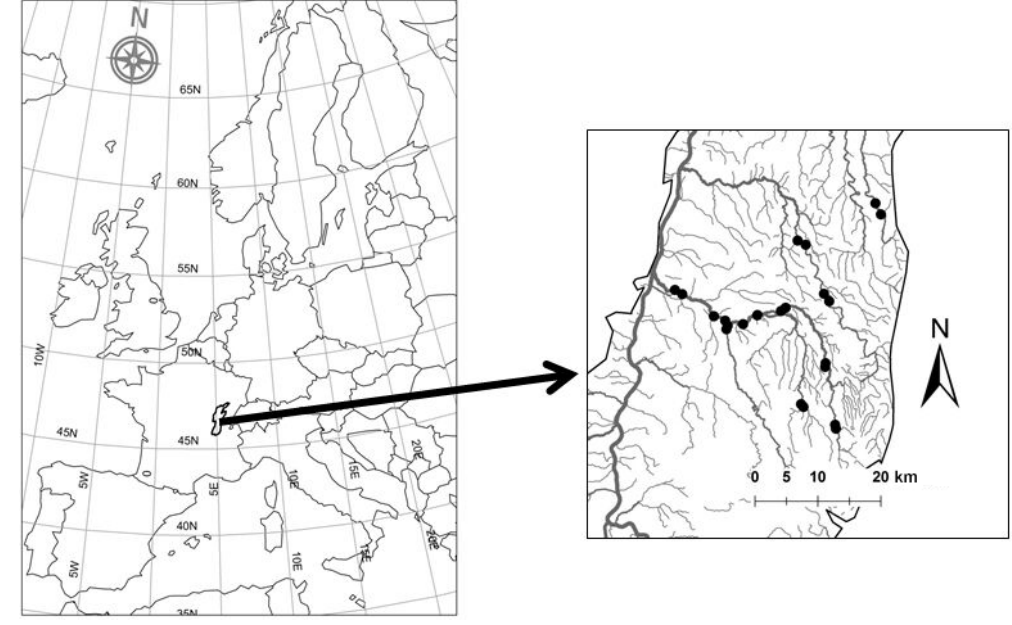
Figure 1. Location of the study area, the Bresse region – the black points on the right map indicate temperature recording